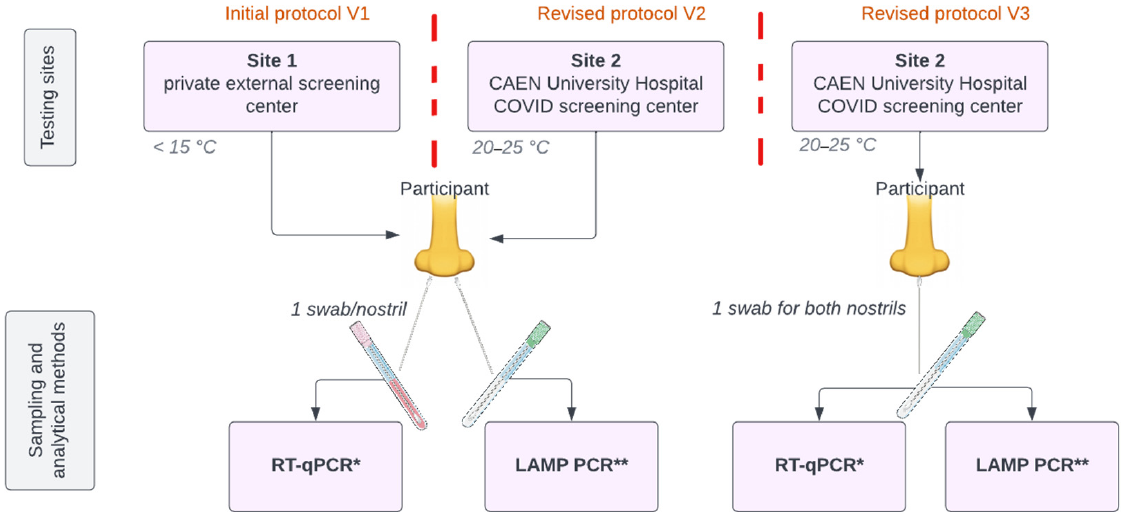
Figure 1. Sampling and testing site modifications. The first line shows the different testing sites and temperature conditions. The second line shows the different sampling and analytical methods. * RT-qPCR: Allplex 2019 n-Cov assay kit, Seegene, Korea. ** LAMP PCR: LoopDeetect COVID-19, LoopDeescience, Caen, France.